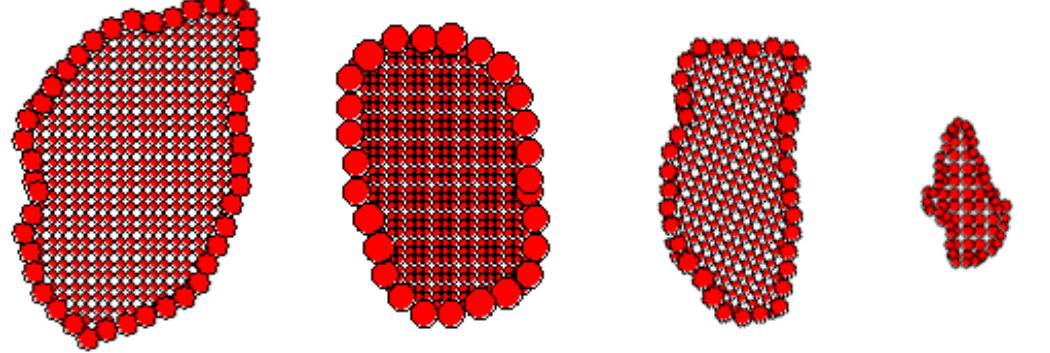
Figure 6. Various virtual particles of different morphological characteristics.